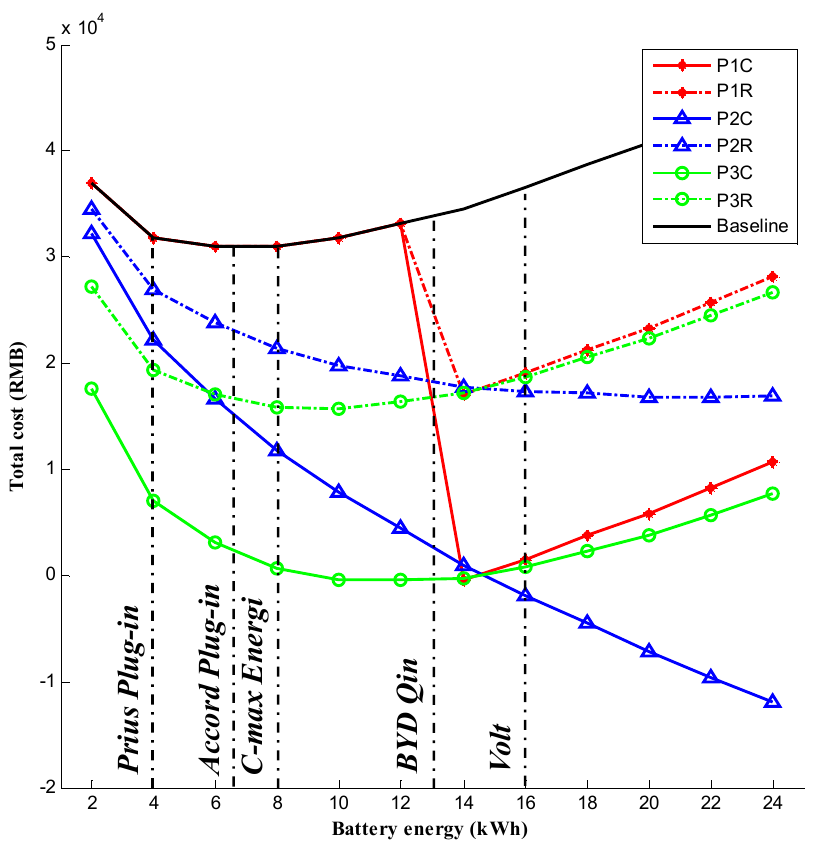
Figure 11. TCO curves after